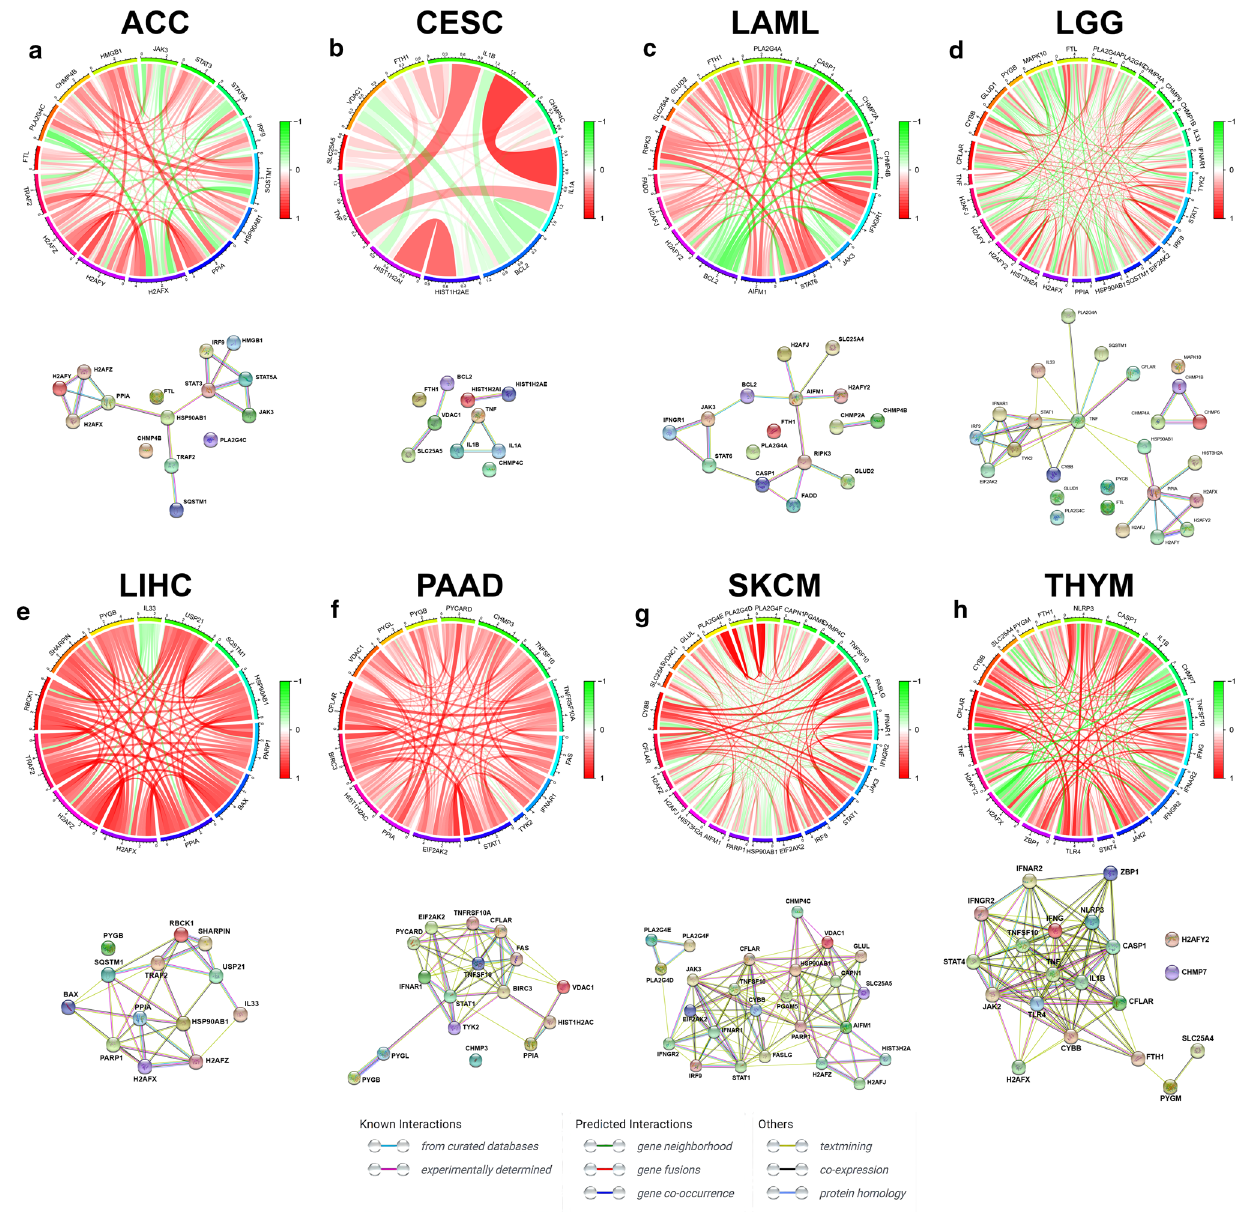
Fig. 2 Correlation among prognostic DENGs. Chord diagrams and protein protein interaction networks ( a – h ) showed the correlation among the prognostic DENGs at mRNA and protein level in the eight cancers. The width and color of the lines between genes in chord diagrams represents the Pearson correlation coefficients and the sources of the protein-interactions were denoted with lines of distinct